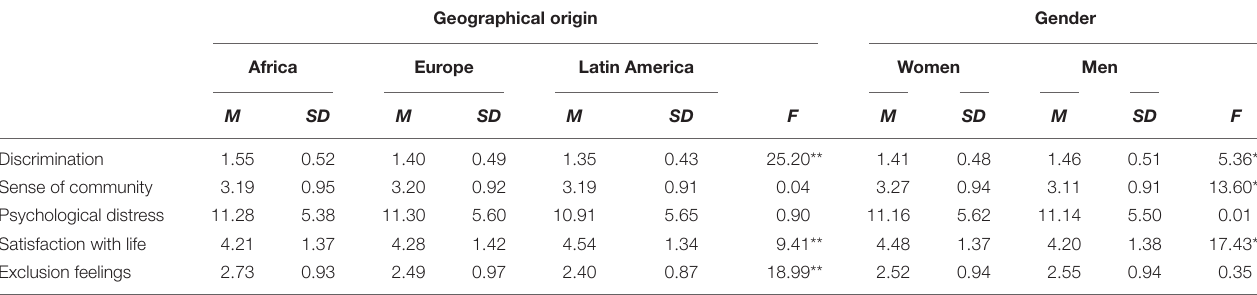
TABLE 2 | Means and standard deviations of key variables by geographical origin and